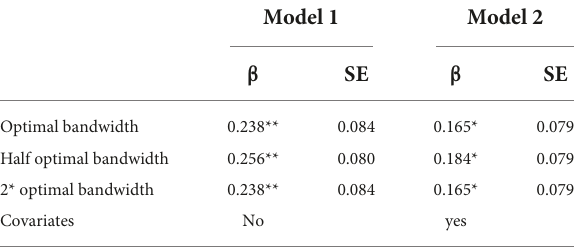
TABLE 5 Results of fuzzy RDD. TABLE 7 Mediation test for the happiness effect of college education, based on KHB